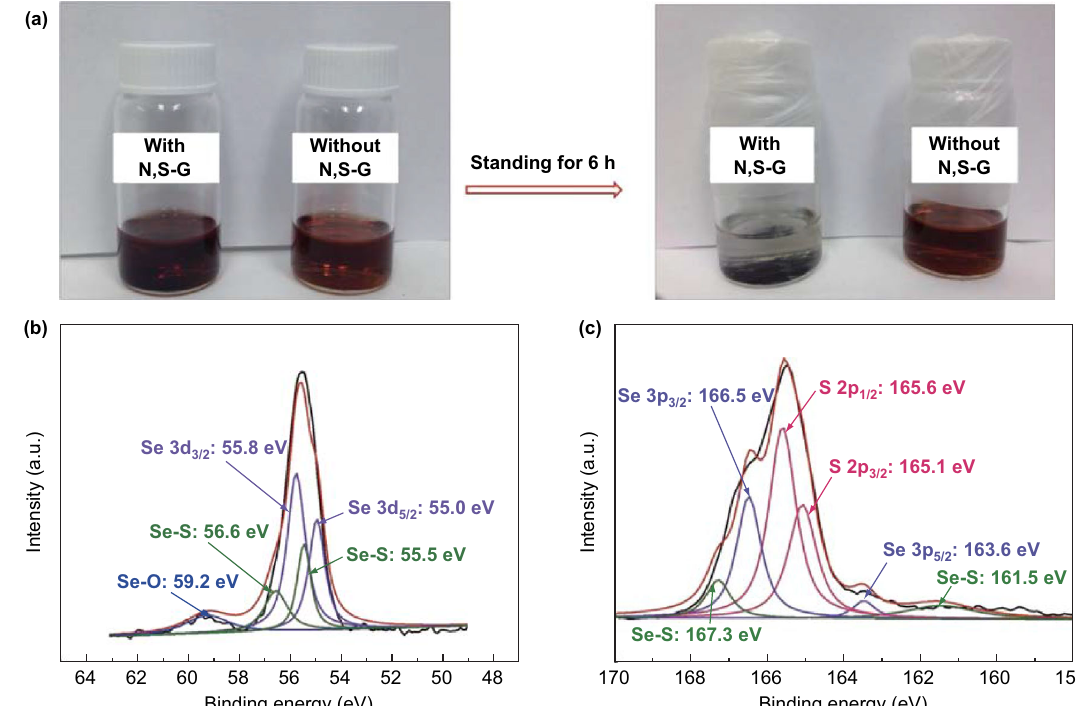
Fig. 7 a Digital photographs of polyselenide adsorption by N,S-G interlayers. High-resolution b Se 3 d and c S 2 p XPS spectra of N,S-G interlayer after 500 discharge